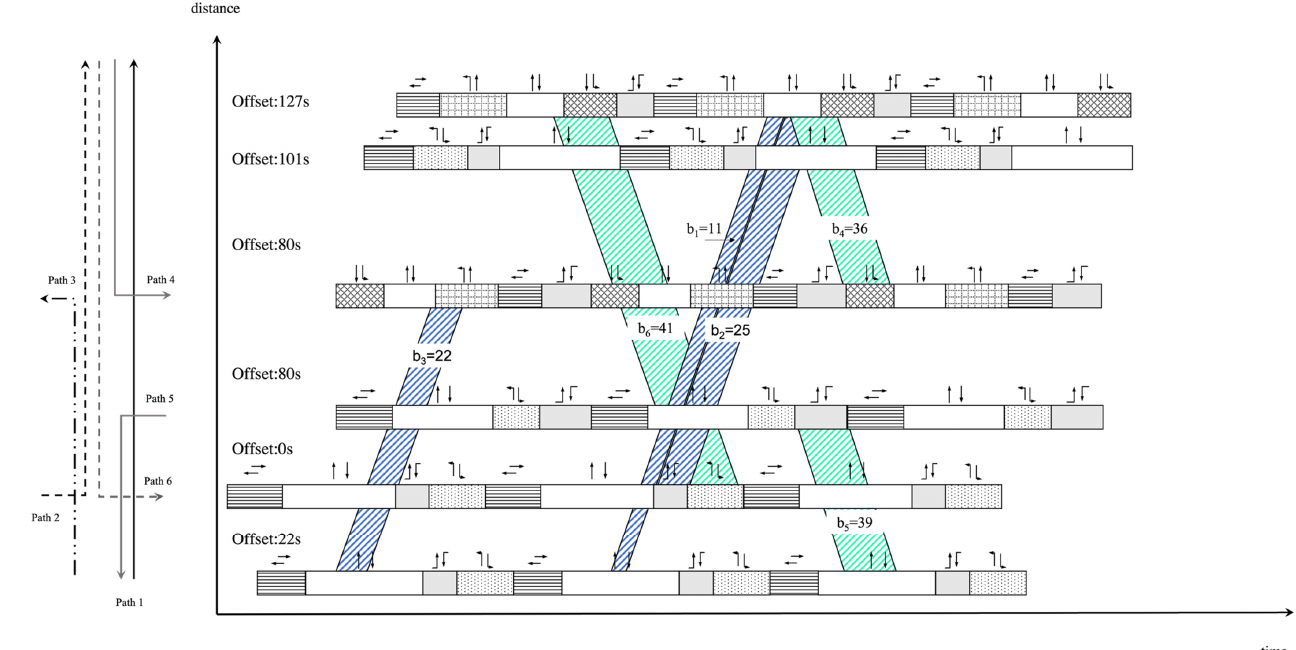
Figure 11. Spatial ‐ temporal variation of green bands obtained by flow mean value (MSD ‐ 𝑟 (cid:3404) 1 ). Figure 11. Spatial-temporal variation of green bands obtained by flow mean value (MSD- r =